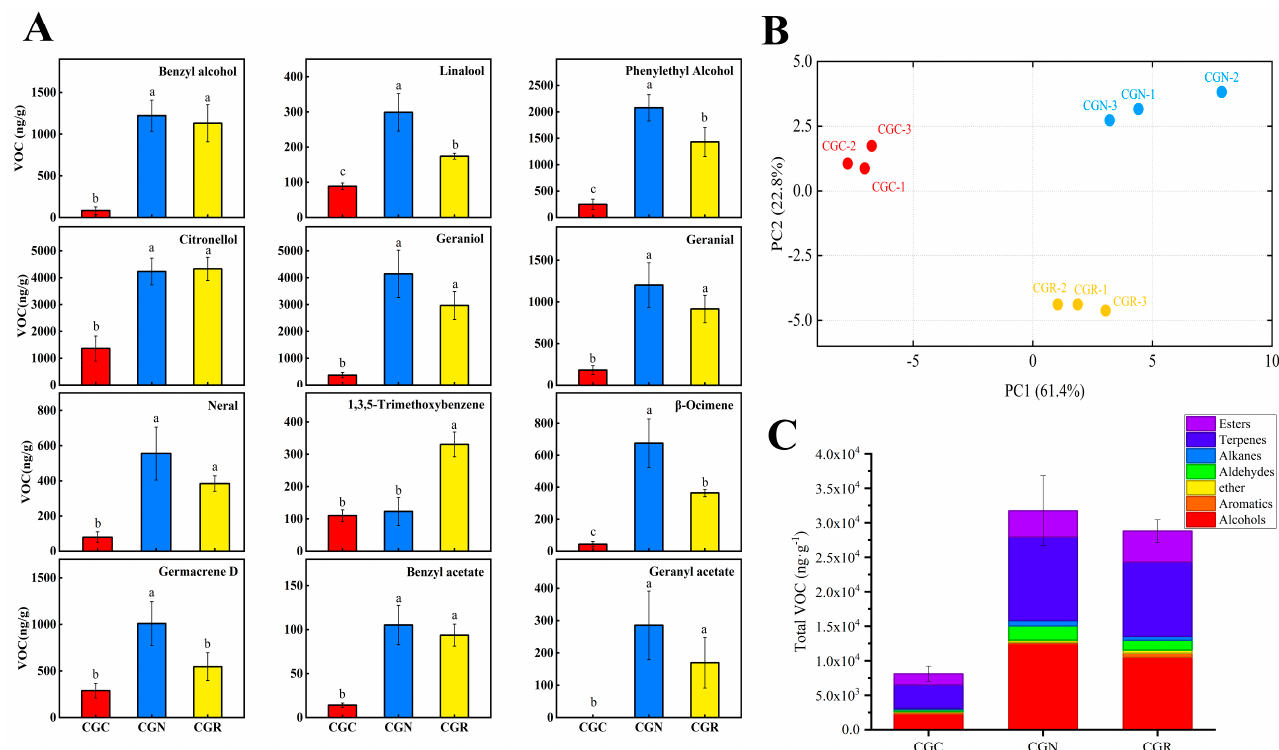
Figure 2. Changes in VOCs in response to different temperatures. CGC, CGN, and CGR refer to storage treatment at 6 °C, 25 °C, and 20 °C. ( A ) Abundance of 12 selected main VOCs composing floral scent emitted from rose. Significant differences ( p < 0.05) are denoted by different letters. The error bars indicate the means ± SEs of three biological replicates. ( B ) PCA results of volatiles in roses in response to different temperatures. The volatiles produced by three biological replicates were used as variables. ( C ) Effects of different temperatures on total volatile emissions, which make up seven groups of compounds.